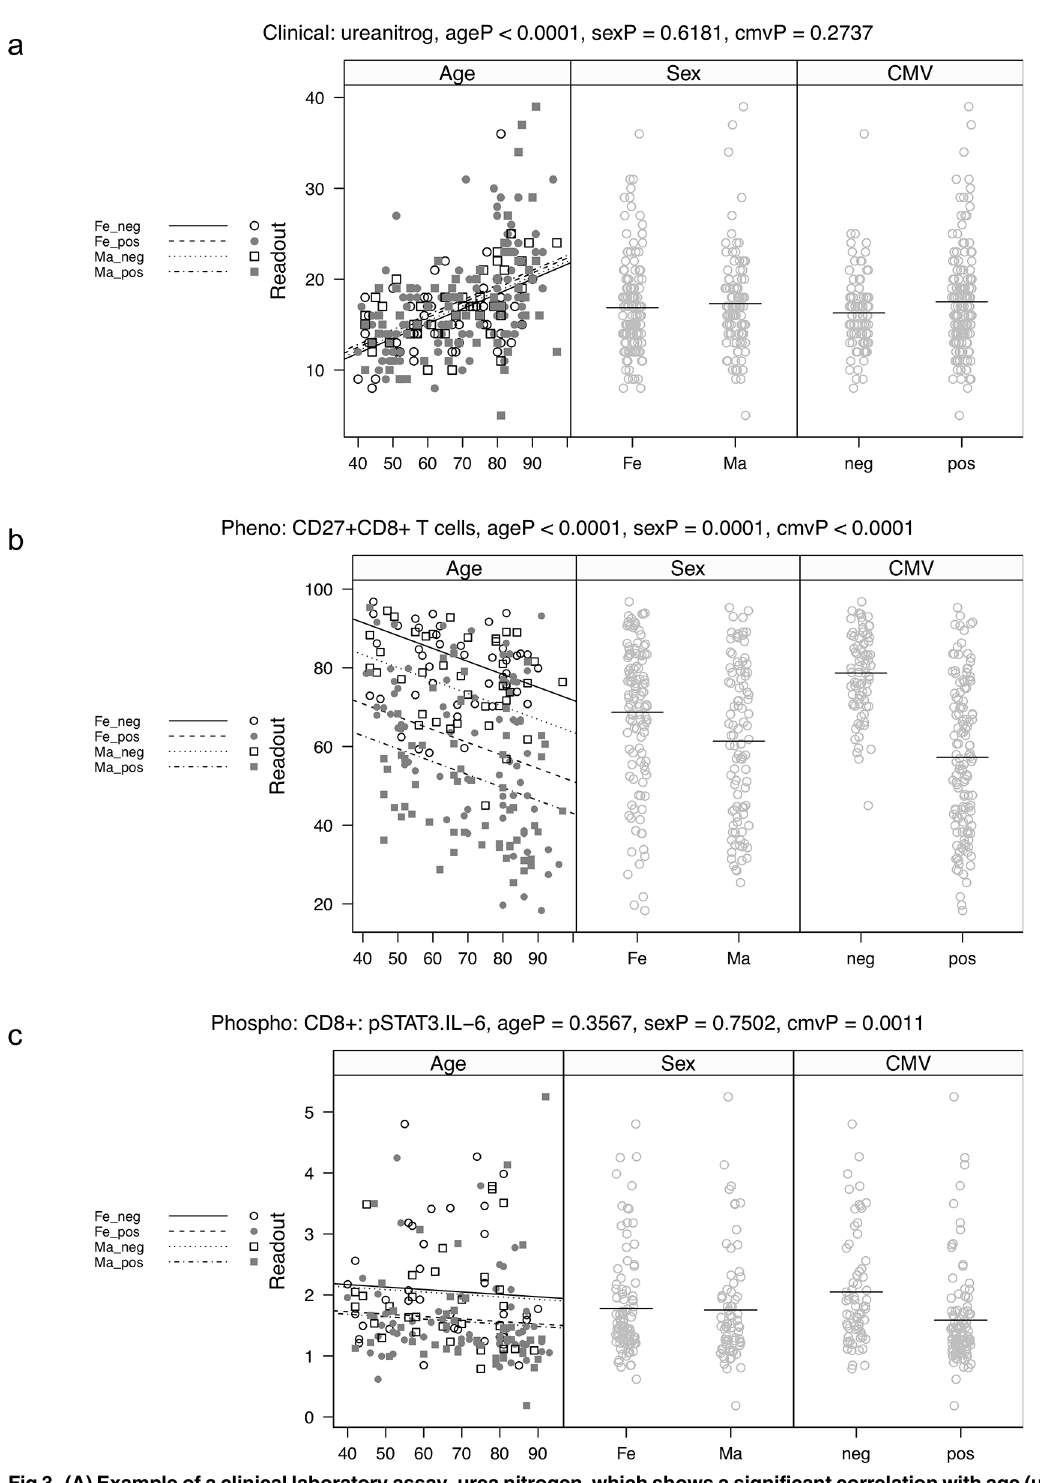
Fig 3. (A) Example of a clinical laboratory assay, urea nitrogen, which shows a significant correlation with age (unadjusted P value = 5.8x10^-15), but not with sex or CMV status. All p-values are unadjusted p-values from a multiple linear regression as described in the methods. The p-values test the significance of the indicated predictor variable, while adjusting for the other two variables. The left most panel (age) shows age versus urea nitrogen, with fitted regression lines for CMV negative females (Fe_neg, solid), CMV positive females (Fe_pos, dash), CMV negative males (Ma_neg, dot), and CMV positive males (Ma_pos, dot dash). Observations from each of these four groups are indicated by different symbols. The second panel (Sex)